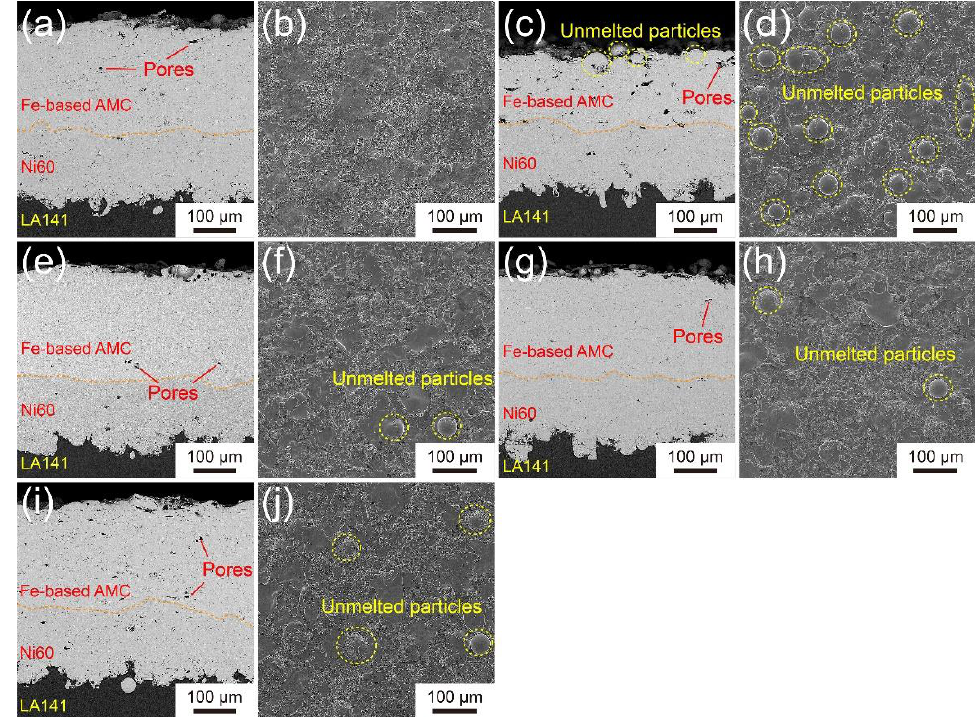
Figure 2. Cross-sectional images and surface images of the Fe-based AMCs on LA141 magnesium alloy: ( a , b ) Coating A, ( c , d ) Coating B, ( e , f ) Coating C, ( g , h ) Coating D and ( i , j ) Coating E.